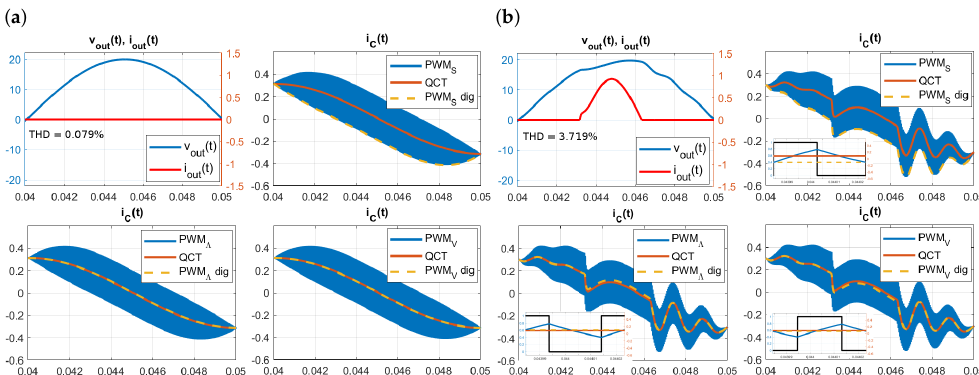
Figure 9. Capacitor current i c ( t ) in the open-loop inverter of Figure 7a using different modulation types compared with QCT output of the model of Figure 7b and the sampled values. The plots in ( a ) are for the no-load system and in ( b ) for the inverter with a RC rectifier load. Observe that for PWM Λ and PWM V the sampled values and the QCT values overlap, and for PWM S they differ. Details are shown for individual sampling periods enlarged in the figures in ( b